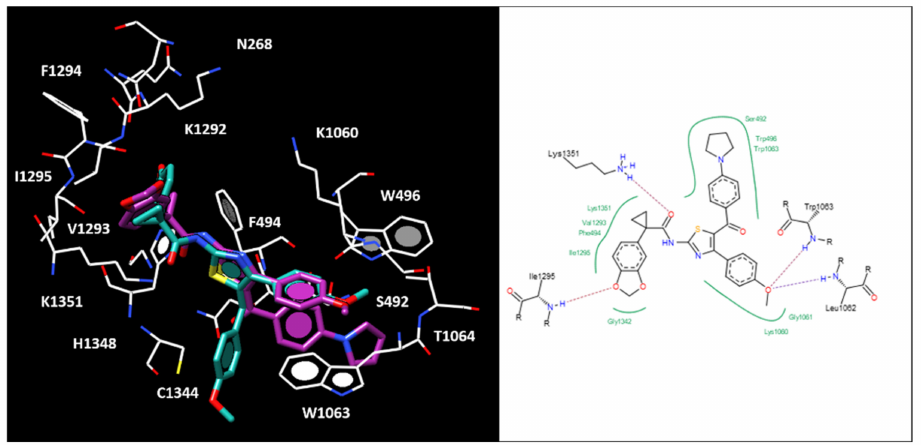
Figure 11. Docking positioning at the modelled F508del-CFTR of 9b (C atom; light sea green) and 9g (C atom; purple). The hybrid 9g ligplot is shown on the